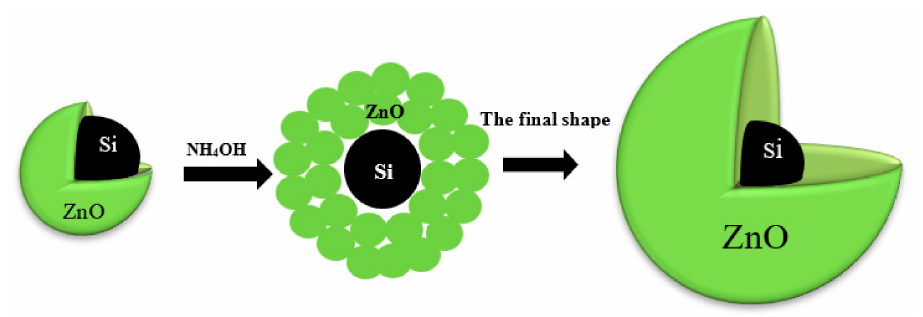
Figure 14. The schematic diagram for the mechanism of NH 4 OH influence on the ZnO